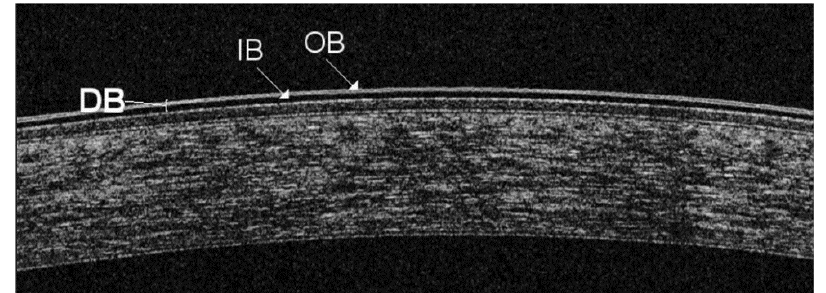
Figure 4. Enhanced imaging of the precorneal tear film (TF) by spectral domain (SD) optical coherence tomography (OCT). Although the axial resolution of SD-OCT systems (~ 5 µ m) is close to the precorneal TF thickness in healthy subjects, TF can be increased in volume by means of an enhancer in order to be detected and monitored over time. Thus, a double-band structure (DB) of the precorneal TF, made by an inner (IB) and outer (OB) layer of opposite reflectivity can be visualized above the central cornea [27]. It is necessary to maintain a predetermined range of temperature (15 ◦ C–25 ◦ C) and humidity (30%–50%) in a dimly lit consulting room to standardize the OCT scanning protocol [4].